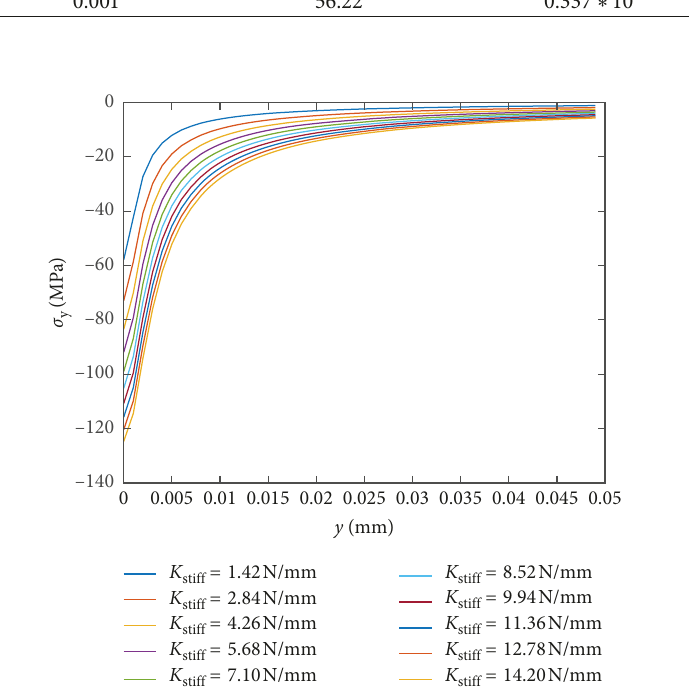
Figure 11: Stress variation along the depth direction under different equivalent spring stiffness.